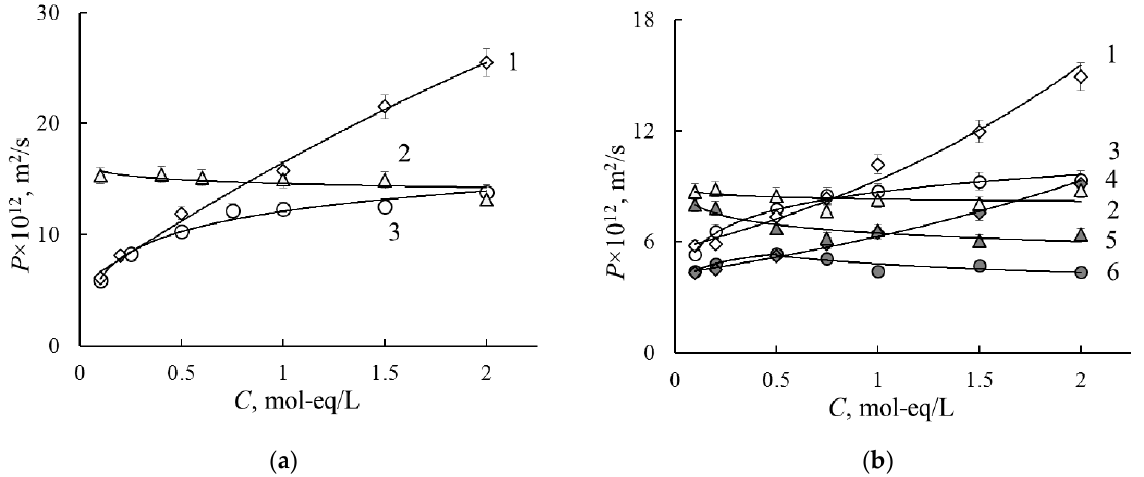
Figure 3. DP concentration dependencies for the MK-40 ( a ) and MK-40/PANI ( b ) membranes in HCl (1, 4), CaCl 2 (2, 5) and NaCl (3, 6) solutions. Membrane oriented by the non-modified (white marks: 1, 2, 4) and modified (gray marks: 3, 5, 6) surfaces to electrolyte flux.